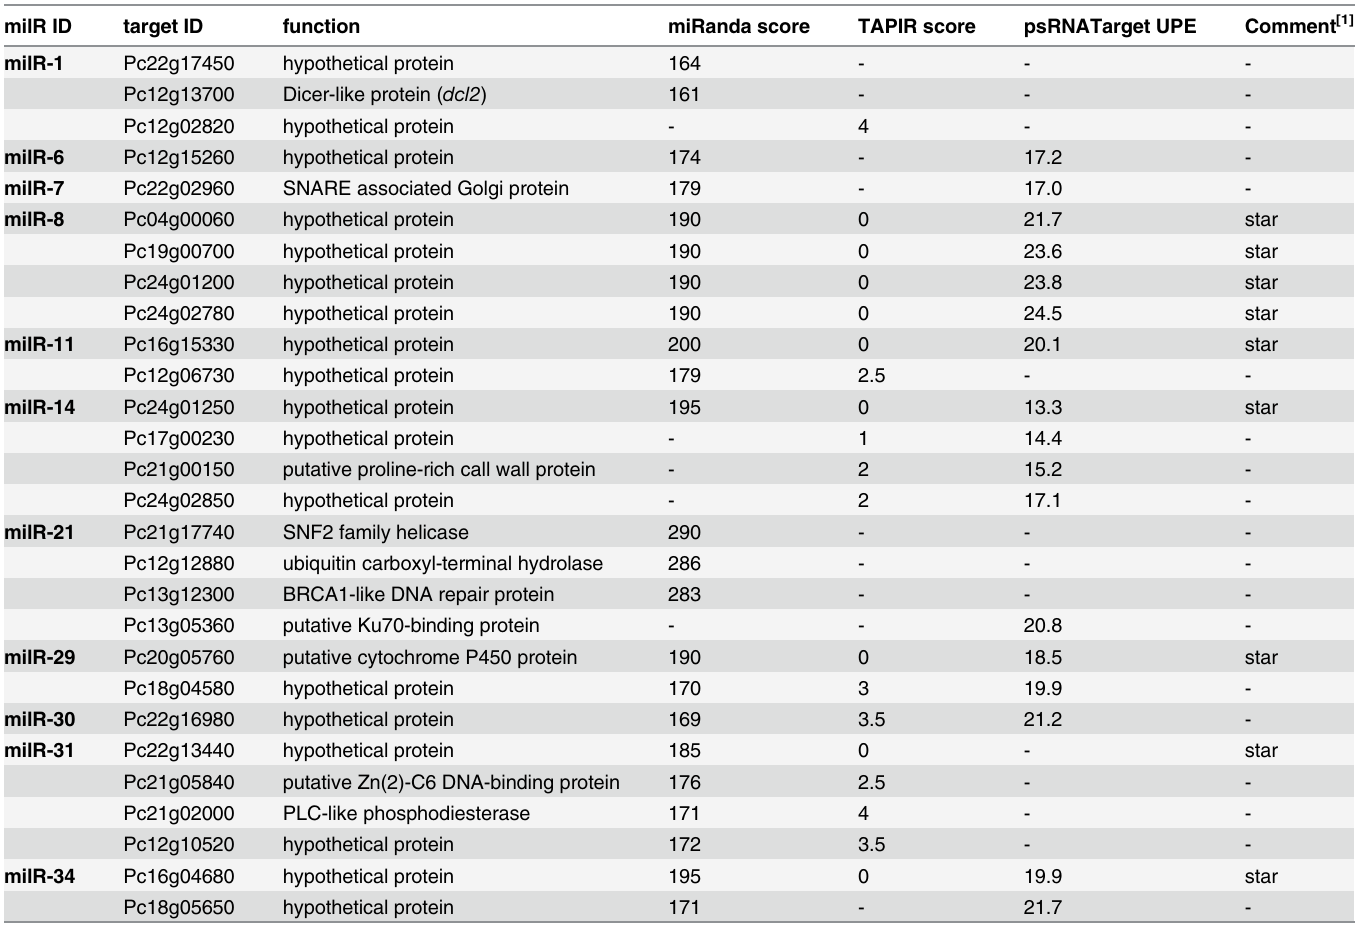
Table 4. milRNA target gene